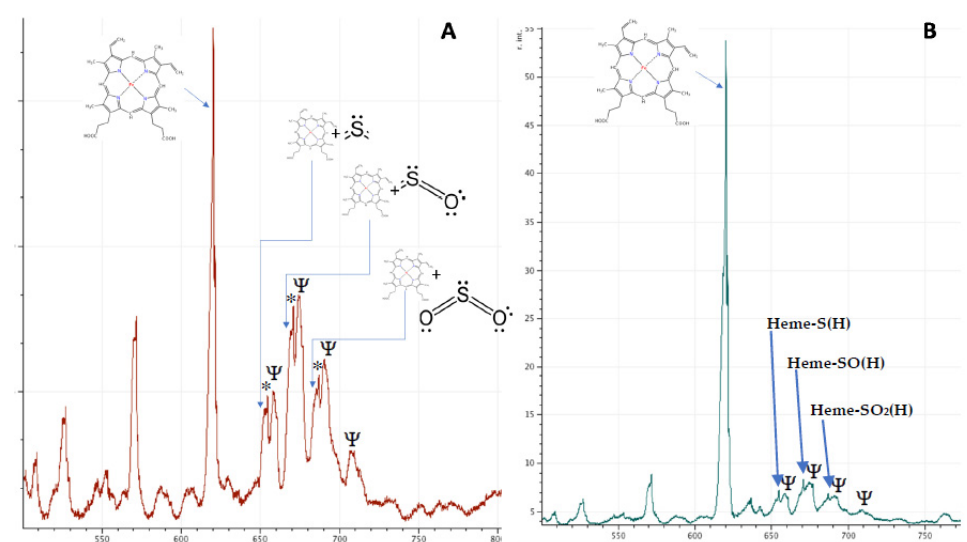
Figure 4. MALDI-ToF mass spectra of patient’s lysed blood demonstrating heme and heme adducts pre- (panel A ) and post-transfusion (panel B ). Positions of heme plus sulfur, sulfur monoxide and sulfur dioxide are indicated by the blue arrows. * indicate satellite peaks corresponding to addition of 1 and 2 m / z to the heme-adduct mass. This is probably due to additional hydrogen atoms. Ψ indicates peaks corresponding to unknown molecules present in the lysed RBCs but significantly abundant at 1 in 1000 dilution.